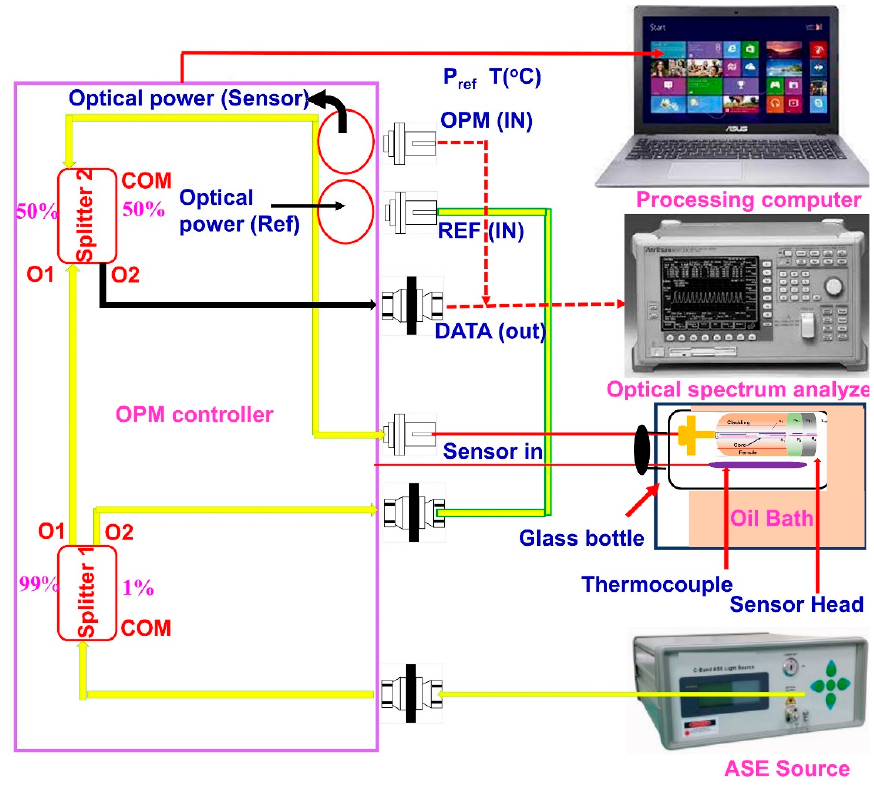
Figure 3. Experimental device setup for measuring the temperature sensitivity of DPFPI sensors.